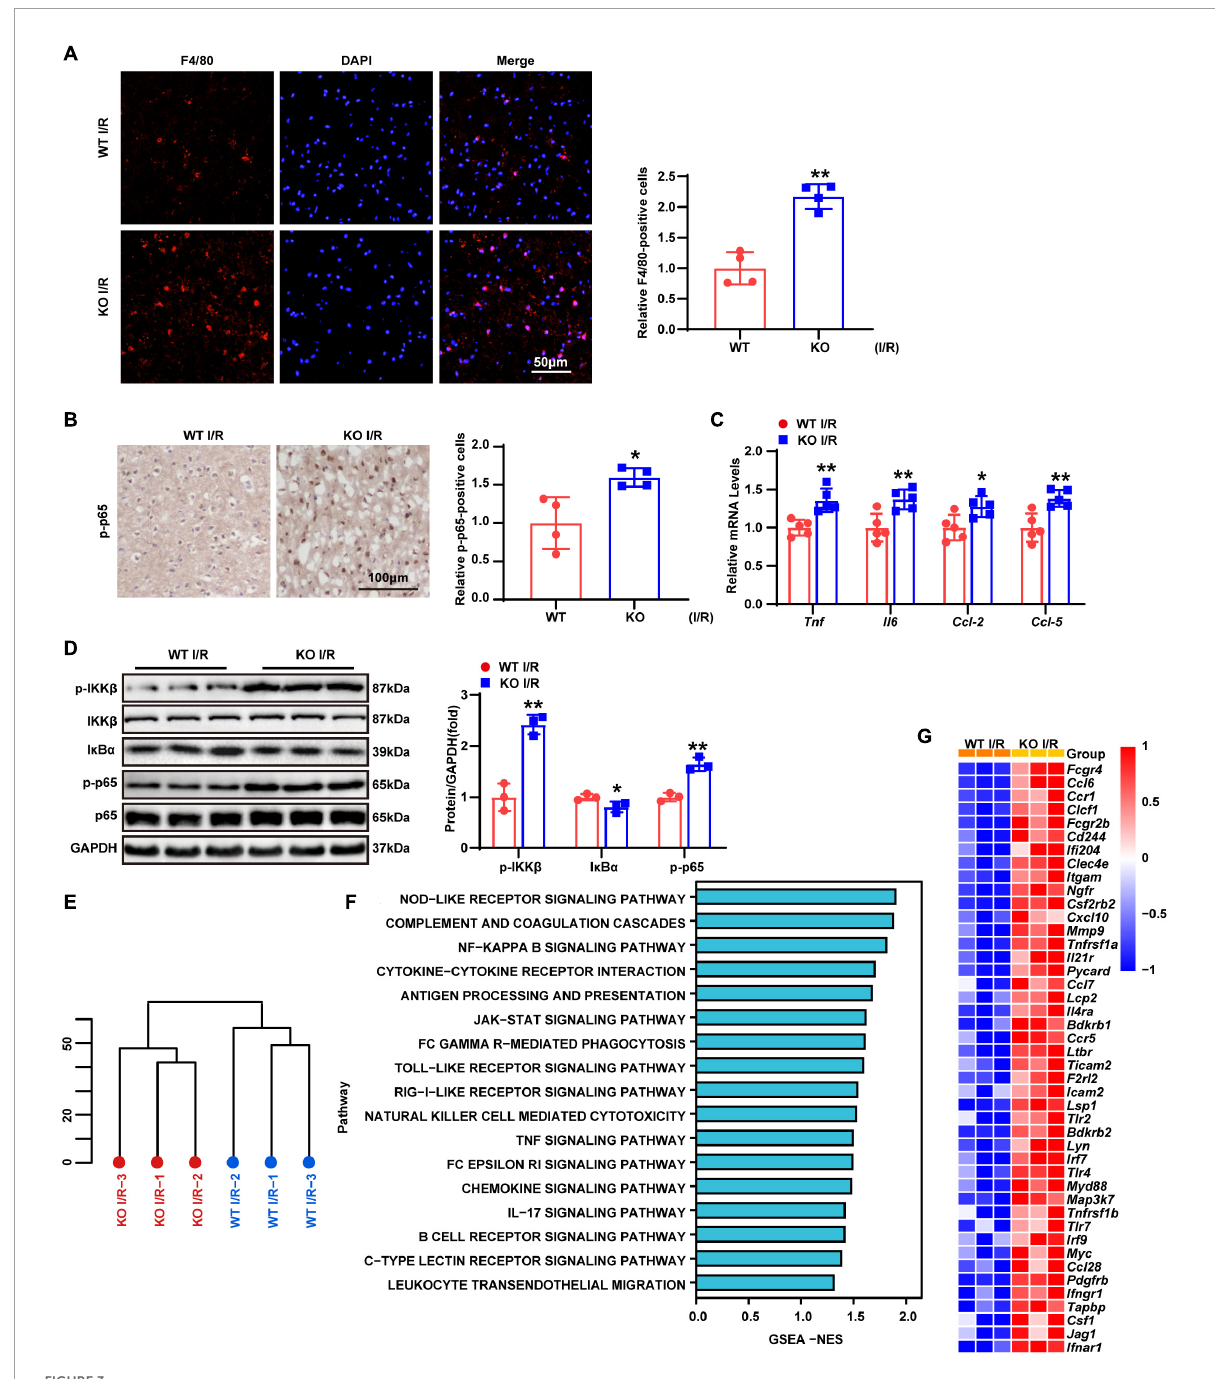
FIGURE3 LAPTM5 deletion facilitates inflammation induced by cerebral I/R injury. (A) Representative images of brain F4/80 staining and quantification (right) showed more macrophages/microglia infiltrating the brains of LAPTM5 KO mice after I/R injury, n = 4 mice per group, ** p < 0.01 vs. WT I/R. Scale bar, 50 µ m. F4/80 (red), DAPI (blue). (B) Representative images of brain p-p65 staining and quantification (right) showed higher percentages of p-p65 positive cells in LAPTM5 KO group subjected to I/R injury, n = 4 mice per group, * p < 0.05 vs. WT I/R. Scale bar, 100 µ m. (C) LAPTM5 KO upregulated the mRNA levels of proinflammatory genes ( Tnf, Il6, Ccl-2, and Ccl-5 ) following I/R injury, n = 5 mice per group, * p < 0.05, ** p < 0.01 vs. WT I/R. (D) Western blot revealed that the protein levels of phosphorylated IKK β and p65 were increased, while that of I κ Ba was decreased in LAPTM5-KO mice after I/R 24 h, n = 3 mice per group, * p < 0.05, ** p < 0.01 vs. WT I/R. (E) Hierarchical clustering analysis showed the global distribution profiles of sequencing data set from brains in WT and TBC1D25-KO mice ( n = 3 mice per group). (F) Gene set enrichment analysis (GSEA) showed the inflammation-related pathway in LAPTM5-KO mice brains based on the RNA-seq data set ( n = 3 mice per group). (G) Heatmap showing the differentially expressed inflammatory genes between LAPTM5-KO and WT mice brains ( n = 3 mice per